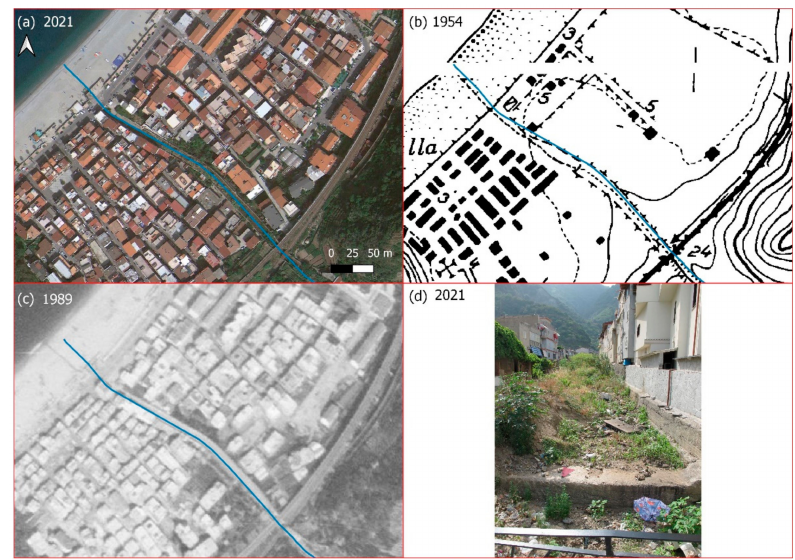
Figure 13. The Gaziano River. ( a ) An image from Google Earth from September 2021. ( b ) The CASMEZ cartography from 1954. ( c ) The orthophoto from 1989. ( d ) The view of the river towards upstream. The blue line is the Gaziano River.